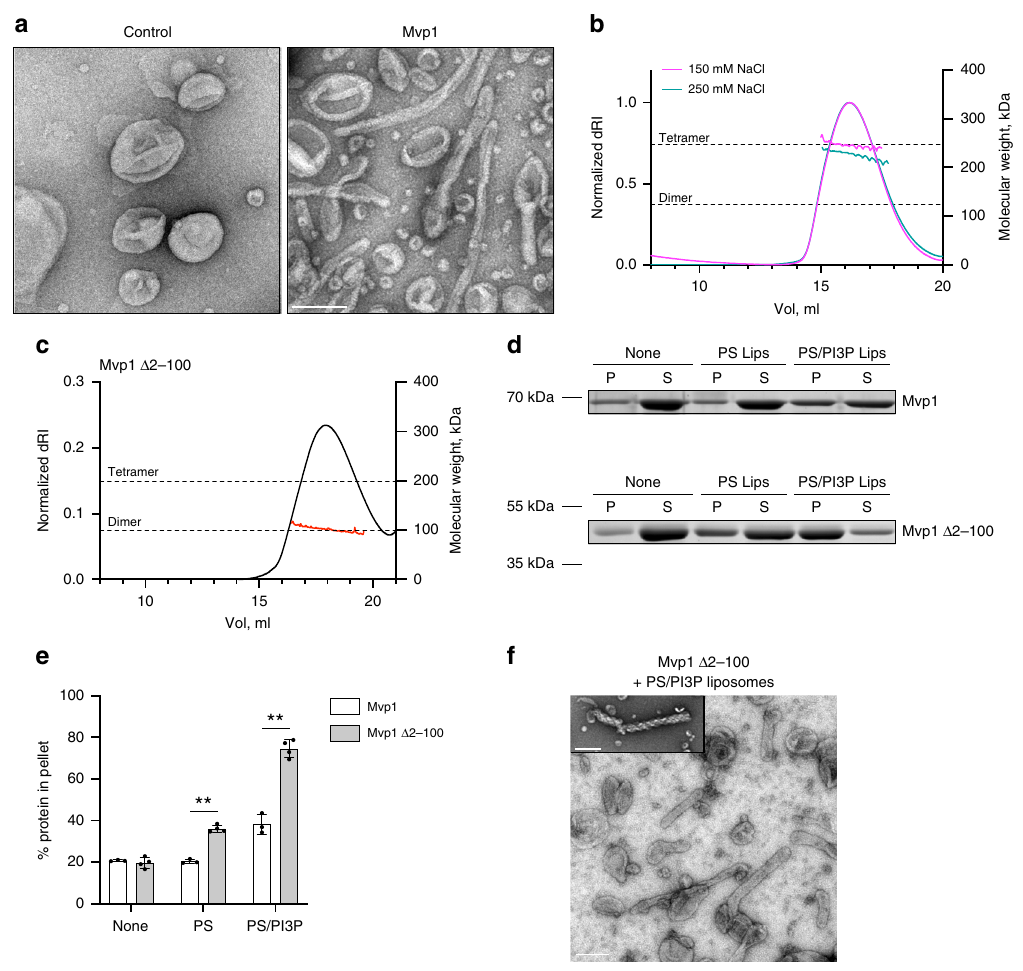
Fig. 1 Mvp1 tetramerization is dependent on its N-terminus. a Mvp1 deforms PS liposomes containing 5% PI3P into irregular tubes. Representative micrographs of negative-stained liposomes incubated either with buffer (control) or with Mvp1. Scale bar — 200 nm. b Mvp1 is a tetramer. The absolute molecular weight of Mvp1 was determined using SEC-MALS. The molecular weight, shown in magenta or teal across the elution peaks, are plotted on the right-hand axis. Theoretical molecular weights of Mvp1 dimers and tetramers, calculated according to the Mvp1 sequence, are shown as dotted gray lines. The differential refractive index of the elutions are plotted on the left-hand axis. Mvp1 was eluted in buffer containing either 150 mM (magenta) or 250 mM (teal) NaCl. c As in b , Mvp1 Δ 2-100 was eluted in buffer containing 250 mM NaCl. d Comparison of liposome binding by Mvp1 and Mvp1 Δ 2-100. Protein (1.2 μ M) was incubated without or with DOPS (PS) or DOPS + 5% PI3P (PS/PI3P) liposomes for 30 min at 21 °C prior to sedimentation. Shown is a representative result. P pellet, S supernatant. Positions of molecular weight markers are shown to the left of the gels. e Quanti fi cation of the results presented in d . Individual data points and mean ± s.d. are shown. n = 3 for Mvp1 and 4 for Mvp1 Δ 2-100. A 3 × 2 factorial ANOVA was conducted to determine the effects of N-terminus (Mvp1 or Mvp1 Δ 2-100) or the absence or presence of liposomes on the % sedimentation of protein. There was a signi fi cant interaction term ( P < 0.0001) and each main effect was also signi fi cant ( P < 0.0001). Selected pairs of values signi fi cant (Tukey HSD) at the 1% level are shown (**). For d and e , source data are provided as a Source Data fi le. f As in a but with Mvp1 Δ 2-100. The inset shows an example of a rare subpopulation of highly twisted tubes observed only when PS/PI3P liposomes were incubated with Mvp1 Δ 2-100. Scale bars — 200